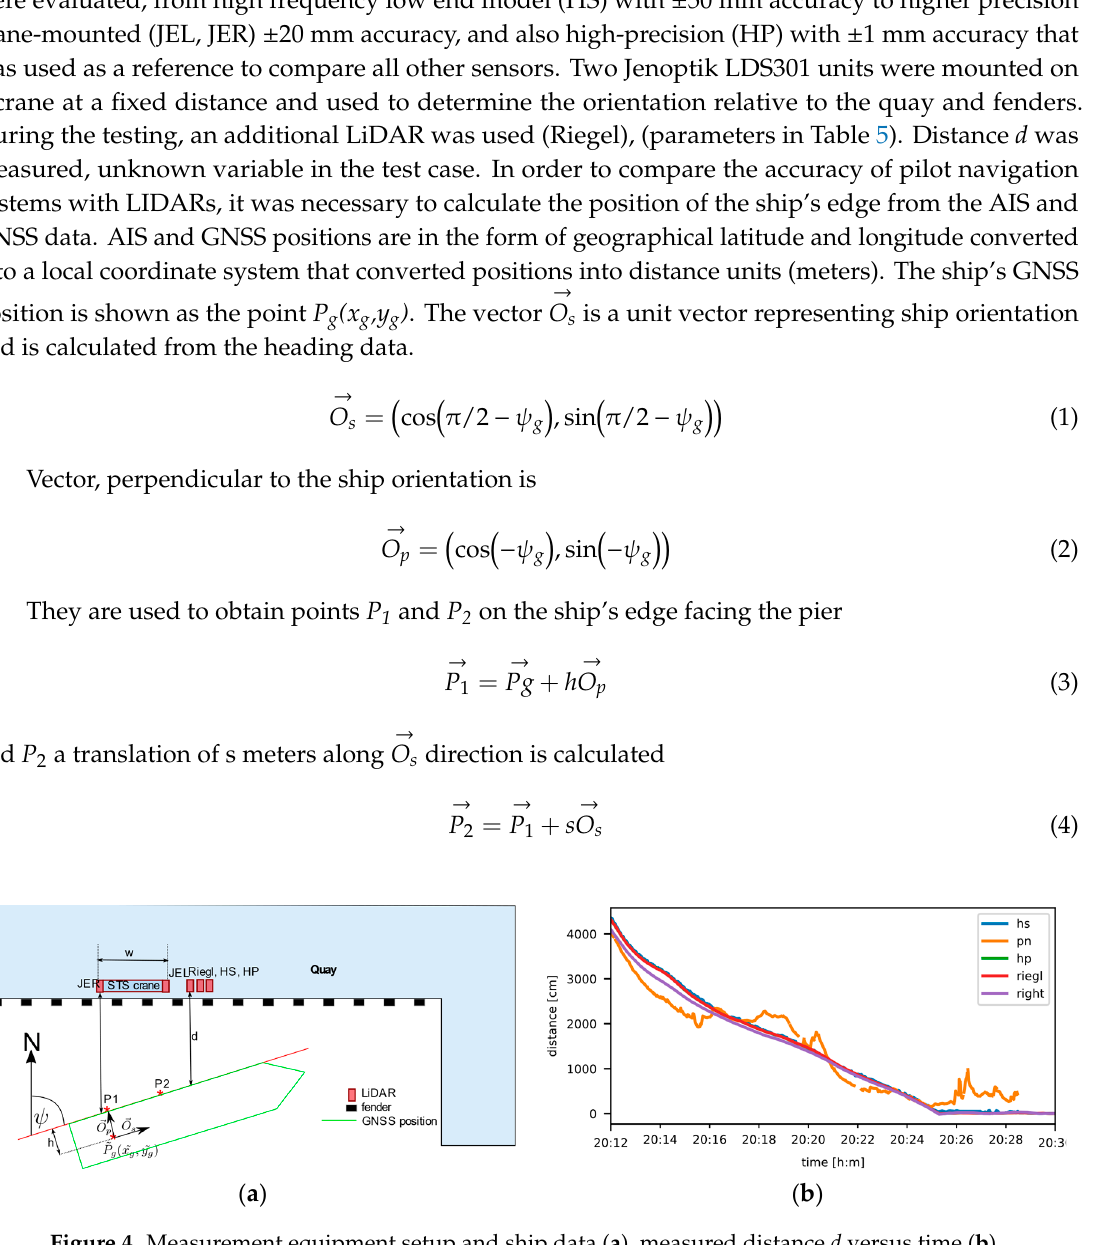
Figure 4. Measurement equipment setup and ship data ( a ), measured distance d versus time ( b ).